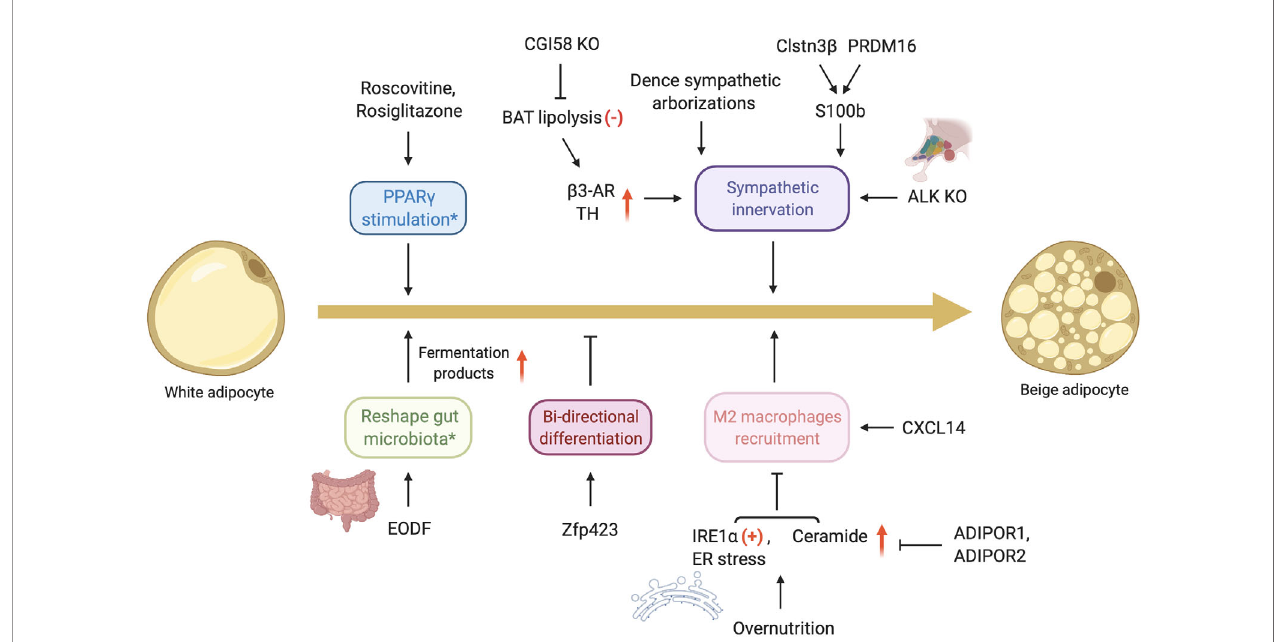
FIGURE 2 | Emerging mechanisms involving in “ beiging ” of WAT. ADIPOR, adiponectin receptors; ALK, anaplastic lymphoma kinase; AR, adrenergic receptor; CGI- 58, comparative gene identi fi cation-58; Clstn3 b , calsyntenin 3 b ; CXCL14, C-X-C motif chemokine ligand-14; EODF, every-other-day fasting; ER, endoplasmic reticulum; IRE1 a , inositol-requiring enzyme 1 a ; PPAR g , peroxisome proliferation-activated receptor gamma; PRDM16, protein PR domain containing 16; TH, tyrosine hydroxylase; Zfp423, C2H2 zinc- fi nger protein. The content in the boxes corresponds to the relevant mechanism and the asterisk indicates the progress of “ beiging ” does not involve b -adrenergic pathway. The signs ( +/- ) in red represent the activation/inhibition status while the arrows in red mean the elevating level of related substance. Figure created using BioRender